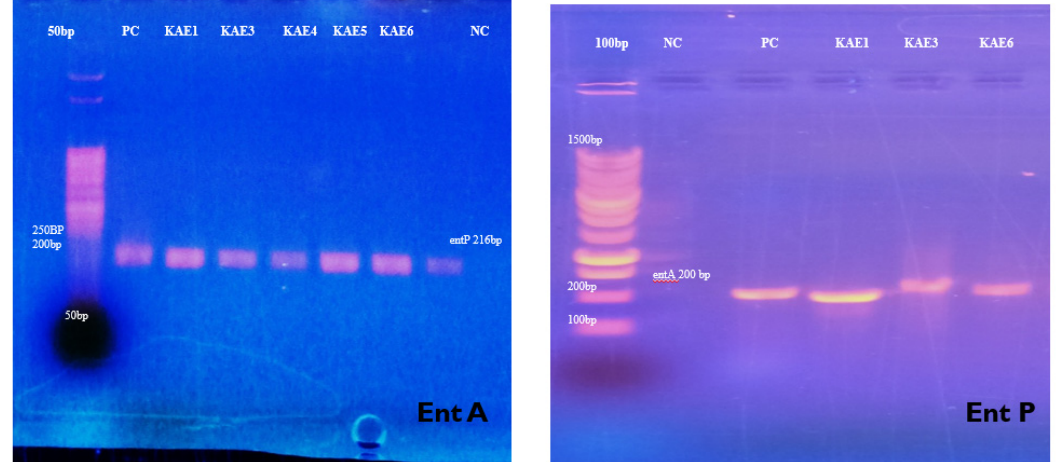
Figure 3. Agarose gel electrophoresis of EntA and EntP genes showing bands at 200 bp and 216 bp, respectively.